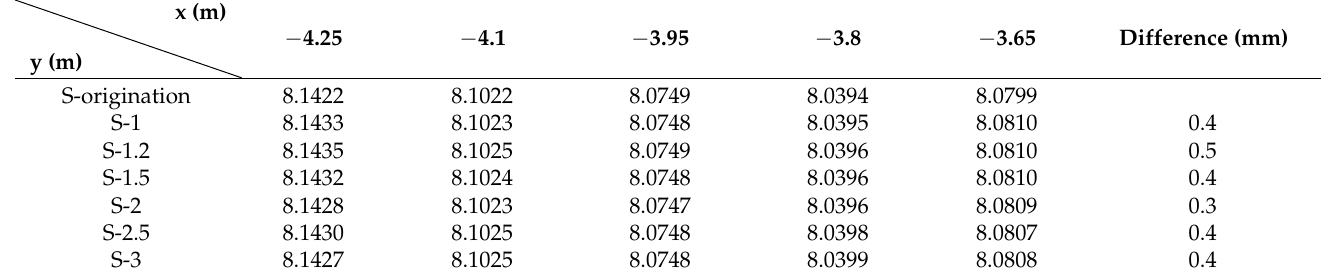
Figure 10. The fitted curves of the cross-section of NS-LS: ( a ) The fitted curve of S-origination; ( b ) The fitted curve of S-2. In Figure 10, points on the x -axis are selected at equal intervals and the y values of the fitted curves are calculated as shown in Table 12. The results shown in Table 12 indicate that the average difference of data with various densities is small, and the minimum difference is achieved for S-2. Table 12. Comparison of data points of NS-LS.